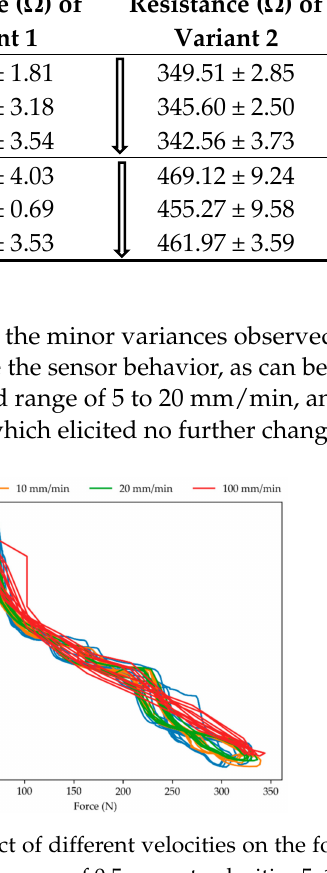
Table 5. Relative extreme values in resistance, shown as percentage of the initial resistance value R0.